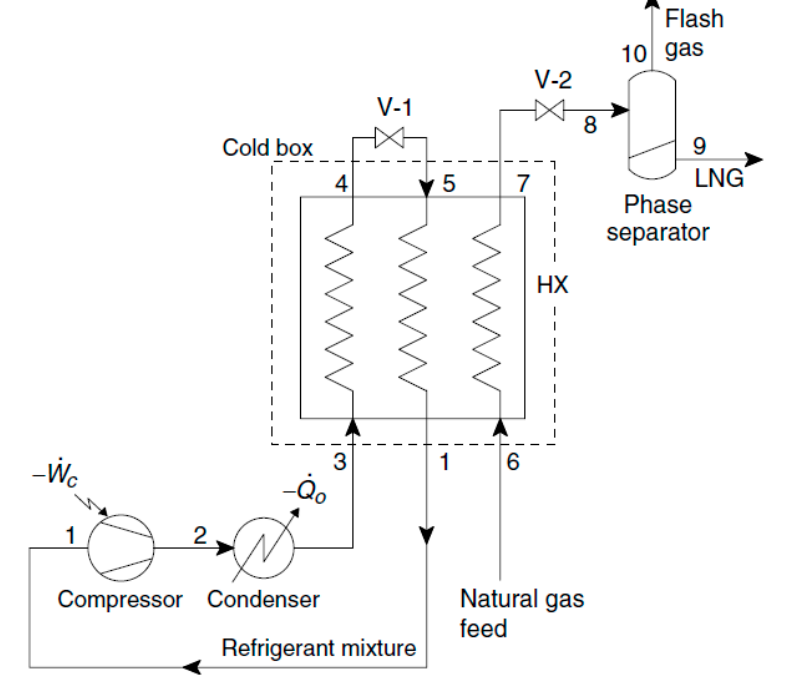
Figure 1. Poly Refrigerant Integrated Cycle Operations (PRICO) cycle (Liquefied natural gas (LNG)).